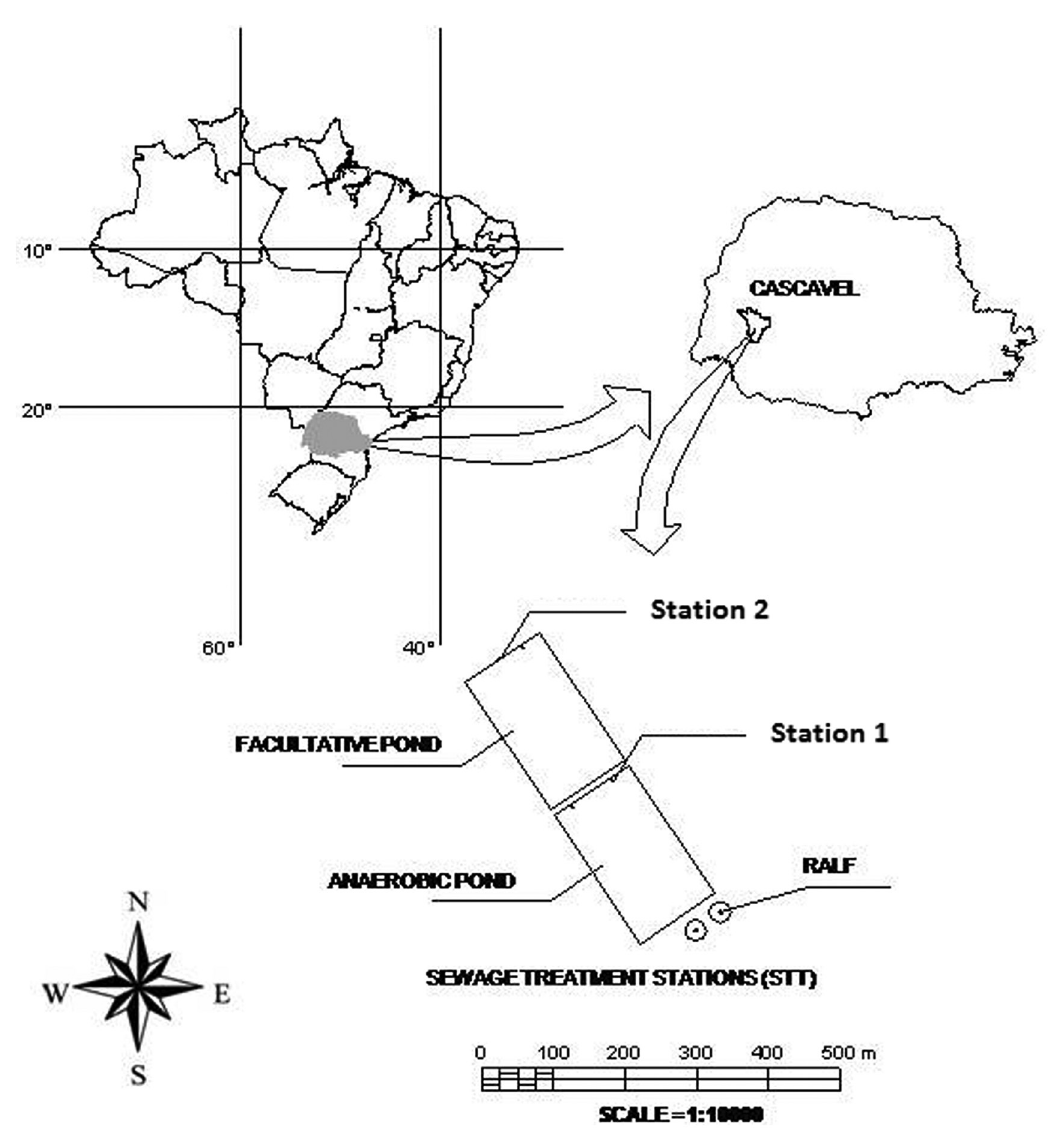
Figure 1. Map and location of sampling stations in stabilization ponds, Cascavel, Paraná, Brazil (RALF - Anaerobic Fluidized Bed Reactor – RALF/UASB, primary